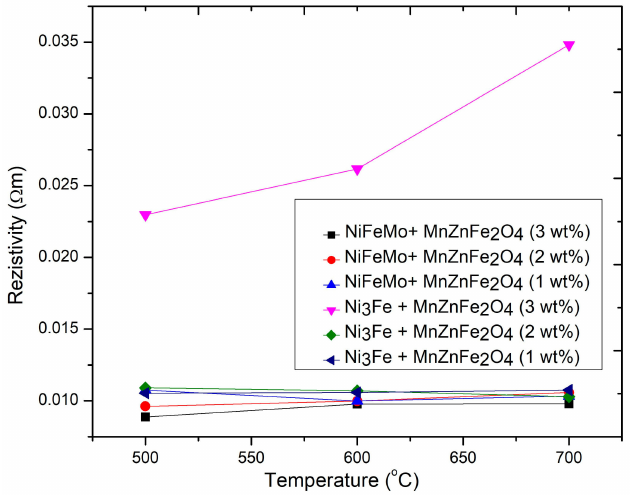
Figure 4. Influence of the amount of ferrite nanoparticles and the sintering temperature on the electri- cal resistivity of composite compacts obtained by SPS from (N 3 Fe, supermalloy) @Mn 0.5 Zn 0.5 Fe 2 O 4 . Sintering time was 0